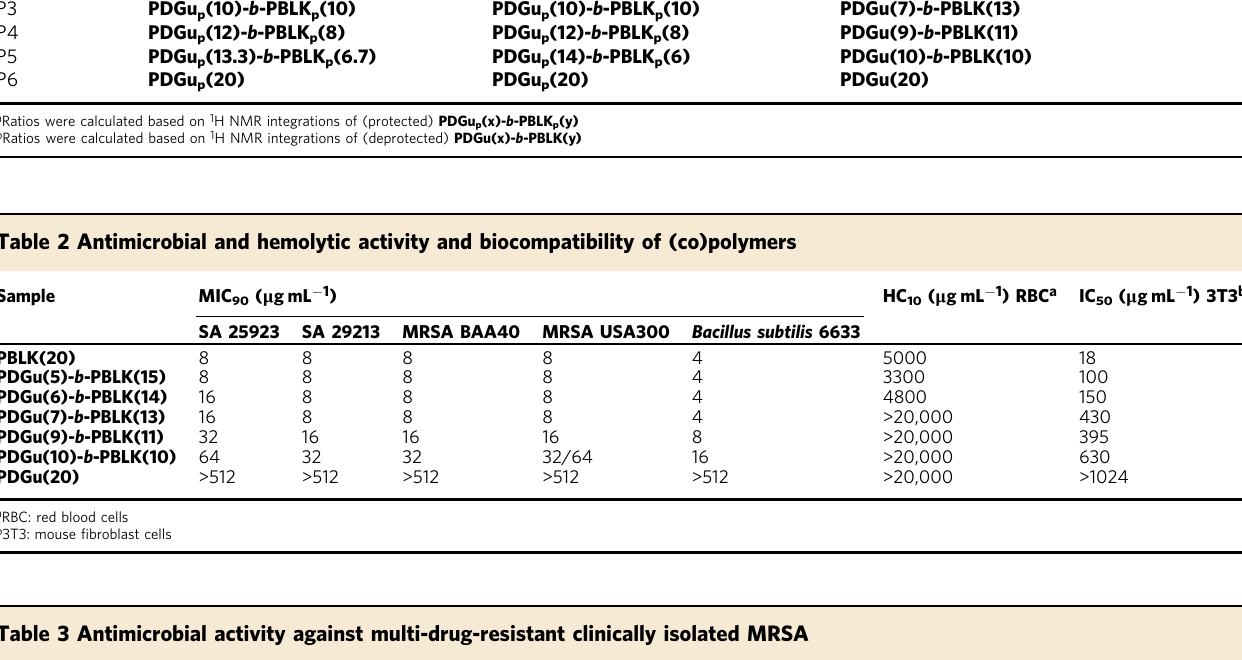
VAN-resistant S. aureus